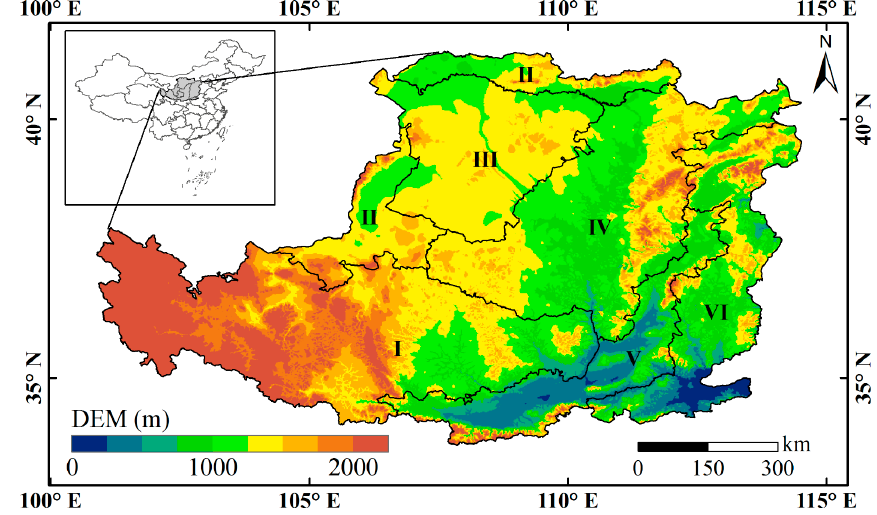
Figure 1. Location of the Loess Plateau and its digital elevation model (DEM). The Loess Plateau covers six natural zones, including (I) the Loess gully region; (II) the irrigation region; (III) the sand and desert regions; (IV) the Loess hilly and gully regions; (V) the valley plain region and (VI) the earth-rock mountain region.